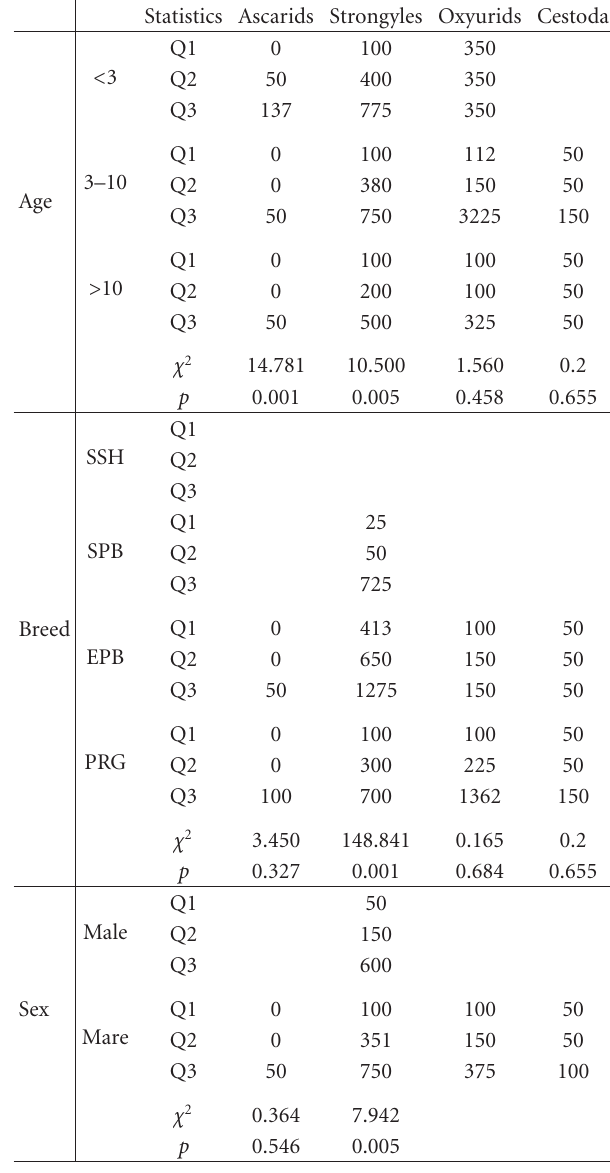
Table 3: Helminth eggs per gram of feces (EPG) in 418 horses from an oceanic climate area (NW Spain). Spanish Sport Horse (SSH), Spanish Pure Breed (SPB), English Pure Breed (EPB); autochthonous Pura Raza Galega (PRG). Results are expressed